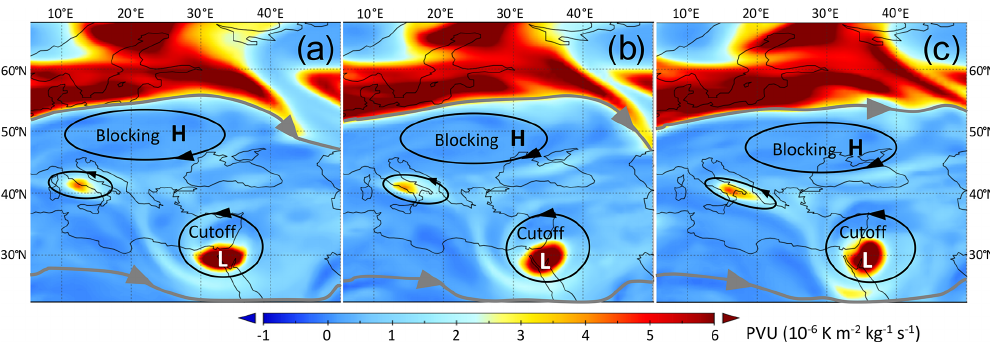
Figure 5. PV distribution at 300hPa starting on 25 April 2018 at 12:00UTC in 6h intervals, covering Europe and the Mediterranean Basin, on which a conceptual sketch of a dipole-type block (following Yamazaki and Itoh, 2013) is superposed. A cut-off low is seen over the south-eastern Mediterranean and a blocking high over eastern Europe, forming a dipole. The arrows show the induced flow of each of the vortices.